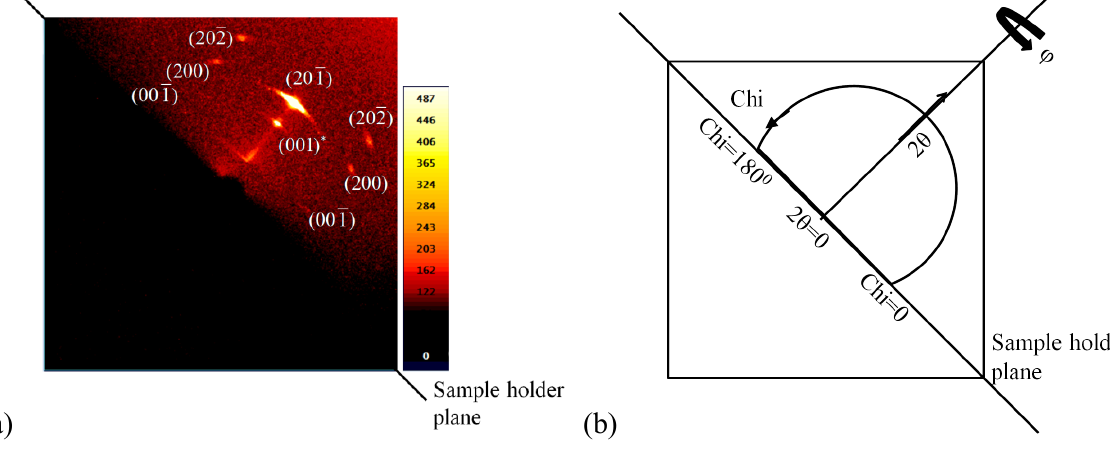
Figure 2. Diffraction intensity versus 2θ plot (obtained by the integration of Chi (0–180°) with GADDS software [14] and PowderCell software